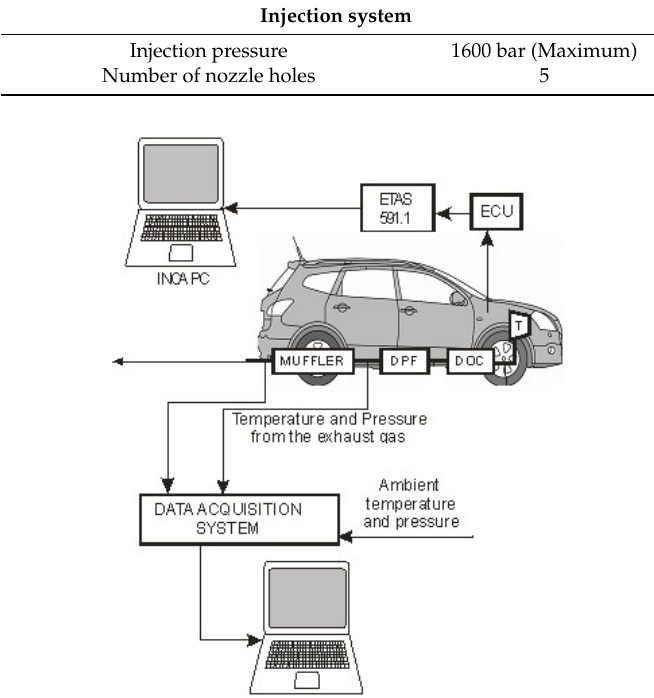
Figure 1. Sketch of the experimental equipment.